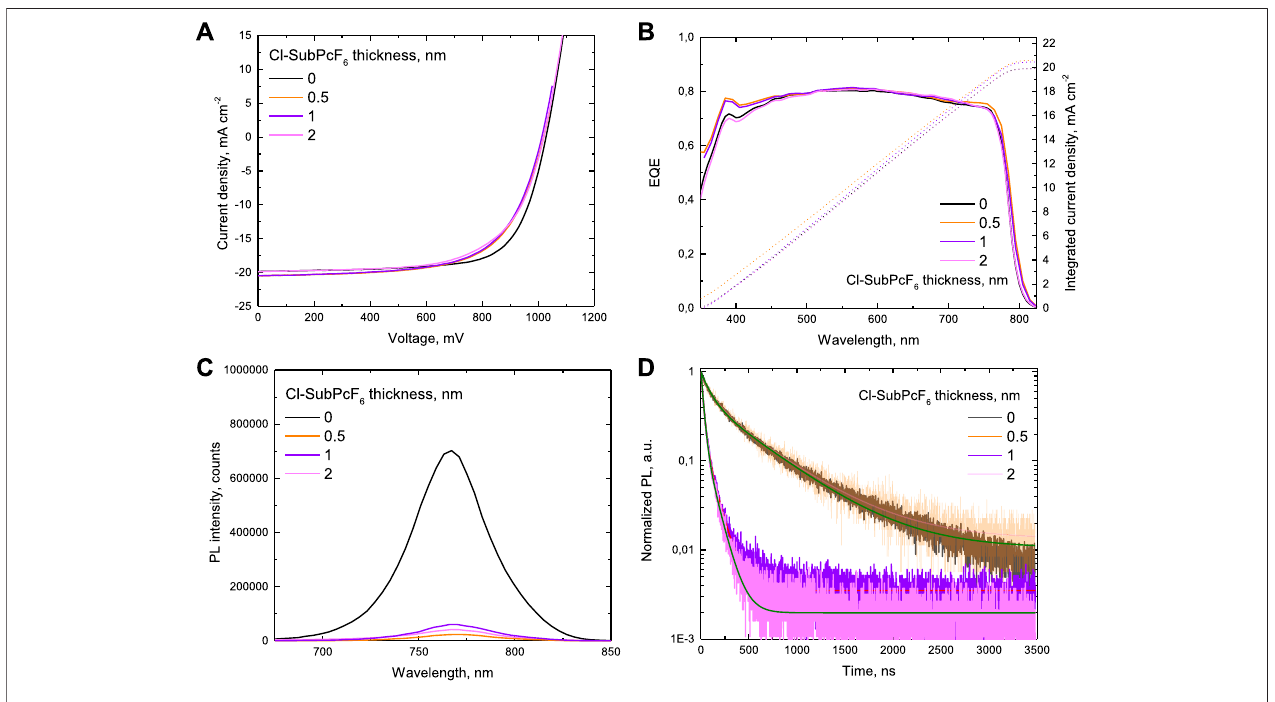
FIGURE6| p-i-n solarcellscontaining Cl-SubPcF 6 /C 60 astheETMwithSubPclayer-thicknessesof2 nm,1nm,and0.5 nm. (A) J – V curvesand (B) EQEspectra of the most ef fi cient devices. The J – V curve and the EQE spectra of the control device (black line) were added for comparison. (C) PL spectra ( λ exc = 475 nm) and (D)